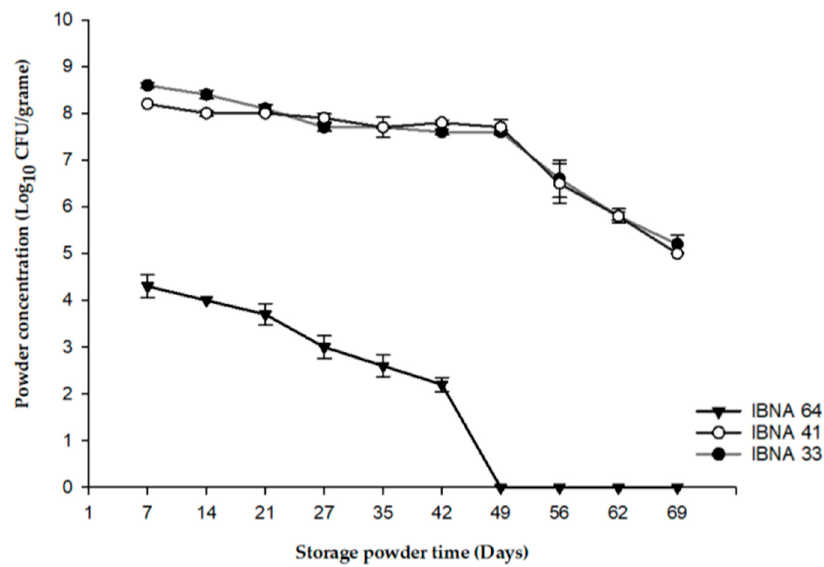
Figure 2. The storage stability of Lactobacillus ( L. salivarius IBNA 33, L. salivarius IBNA 41, L. acidophilus IBNA 64) powders during 62 days at room temperature (25 °C). Data are represented as means ± standard error of means (SEM) of three independent experiments.